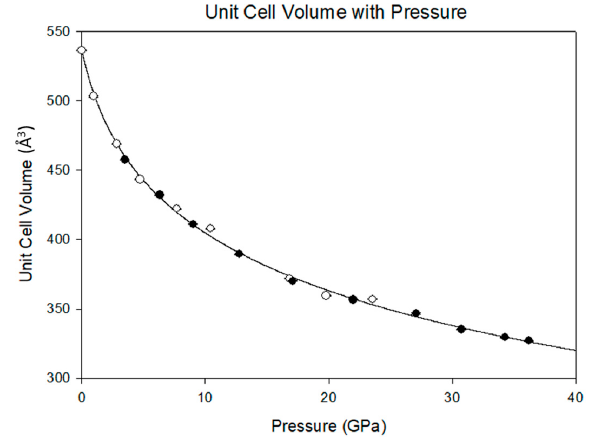
Figure 4. Evolution of unit cell volume of melamine with pressure. Data points were fitted with a third-order Vinet equation of state, V 0 = 536.7(2) Å 3 , K 0 = 12.9(8) GPa, and K ′ = 7.4(3). Open circles indicate 2010 data collected in Ne, filled circles indicate 2015 data collected in He.